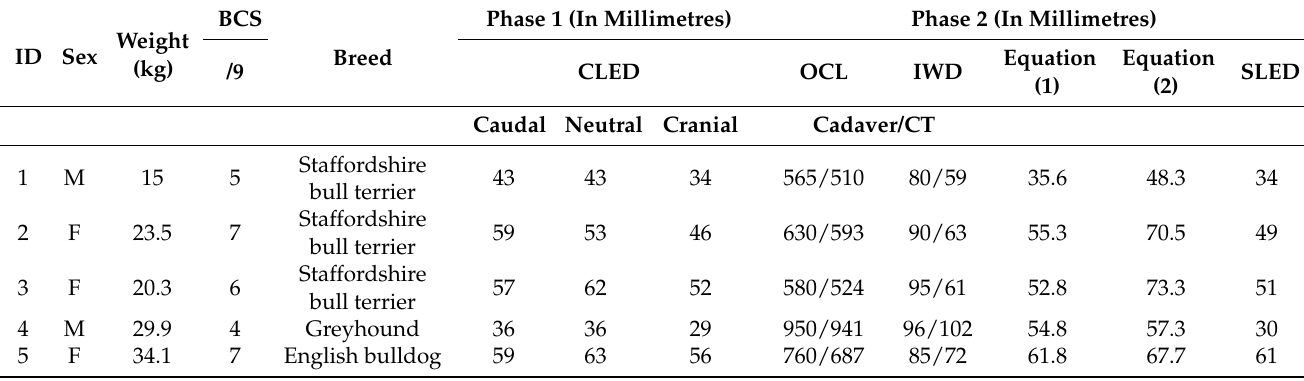
Table 1. Descriptive information for the 11 canine cadavers, the CT derived lumbosacral epidural space distance (CLED) based on three pelvic limb positions (Phase 1), with the predictor and the outcome values for correlation and concordance evaluation (Phase